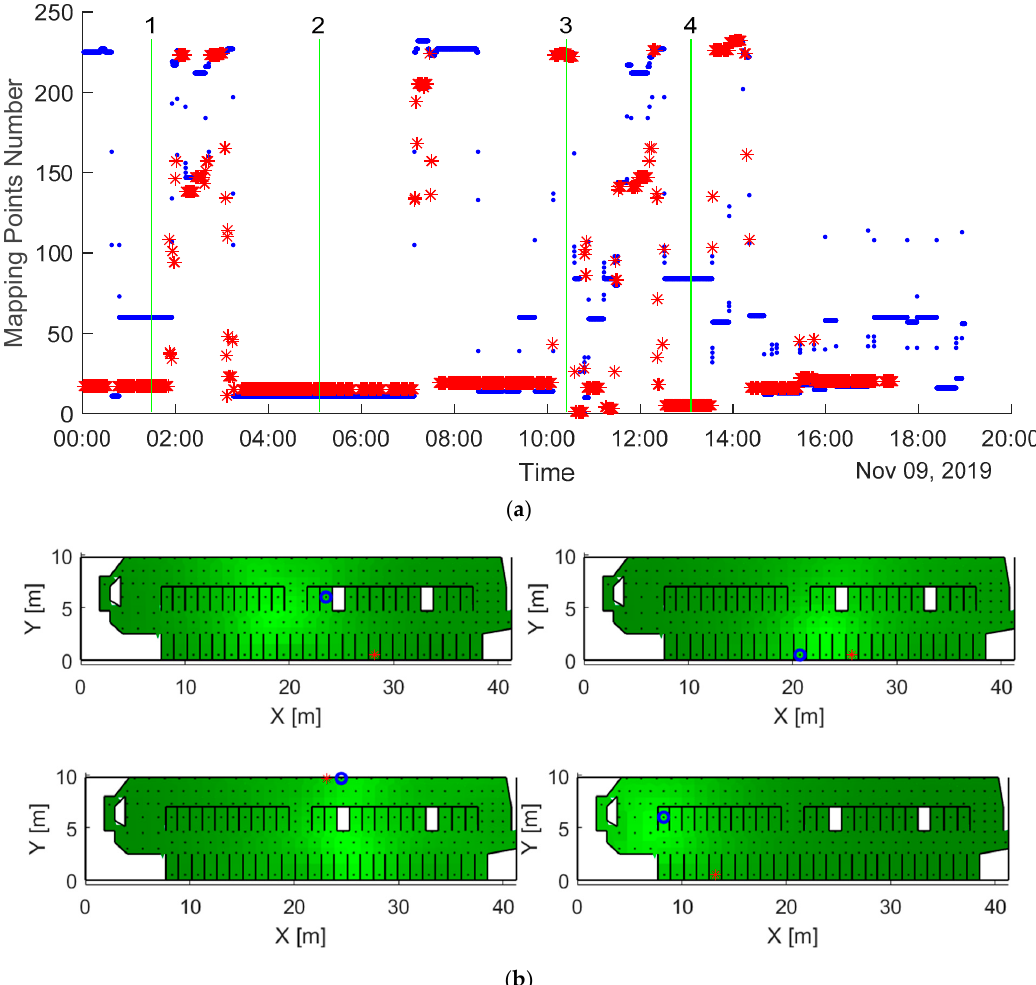
Figure 11. Comparison between the calculated (blue dots) and reference (red asterisks) tag locations during a day ( a ). Sequence of the barn maps with tag localization ( b ) corresponds to the moments signed on ( a ) by horizontal lines 1, 2, 3 and 4 respectively. The green gradient in the heat maps in (b) represents the probability of the tag localization in the mapping points in four instances indicated as green lines in the panel (the lighter the color, the higher the probability). Blue circles represent the calculated tag location, while red asterisks represent the reference. The estimation of the localization accuracy is presented in Figure 12 for experiment 1 (entire barn) (a) and experiment 2 (b) (waiting yard). The localization error for each cow is presented by boxplots. The total average location error (mean ± STD) was 3.27 ± 2.11 m in experiment 1 and 1.9 ± 0.67 m in experiment 2. The numbers of the tags attached to different cows are denoted above the boxplots. The cumulative percentage of the location error for each cow is presented in Figure 12c,d, with the average cumulative percentage represented by the solid line.